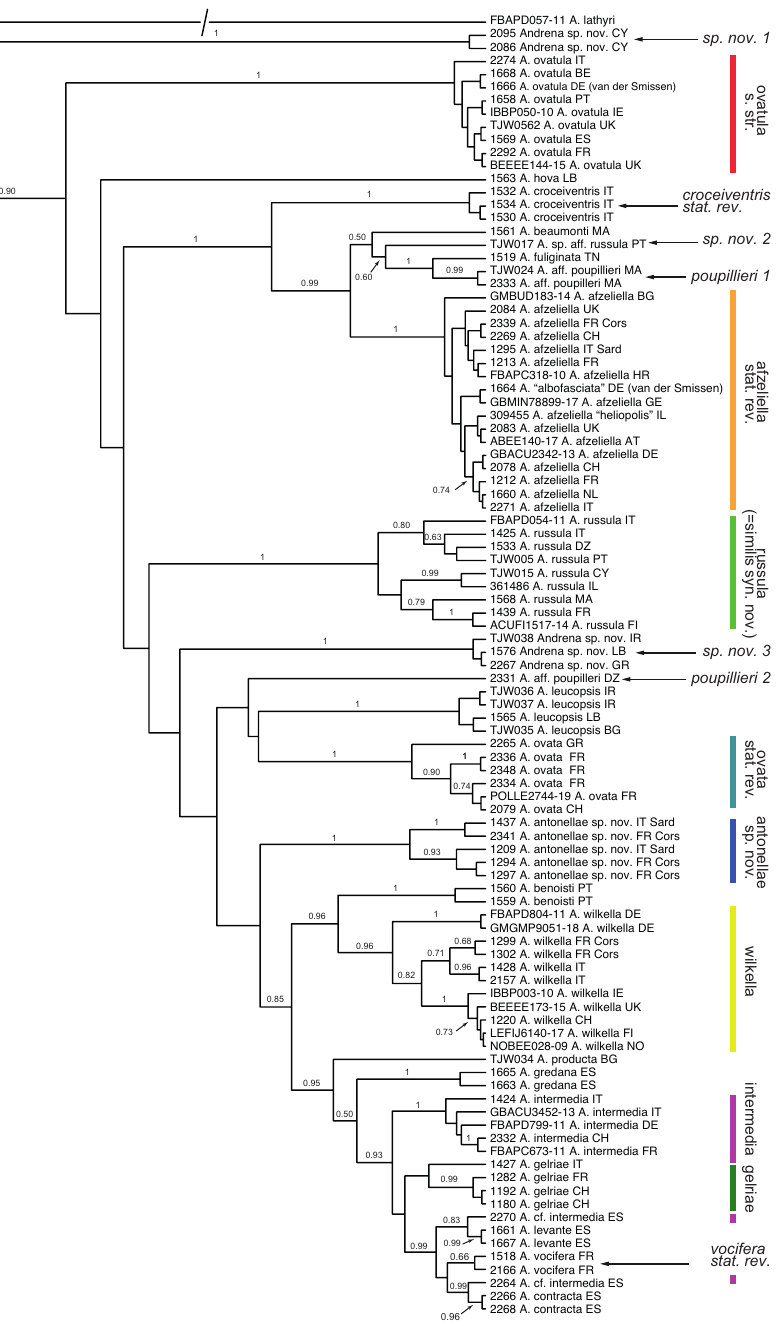
Figure 2. Maximum clade credibility tree found in Bayesian analyses of sequence data of the mitochon- drial gene COI, showing the phylogenetic relationships among the different species of Andrena subgenus Taeniandrena investigated in the present study. Numbers above branches represent posterior probabilities (values < 0.5 are omitted). Taxa mentioned in the text are indicated by arrows or by vertical